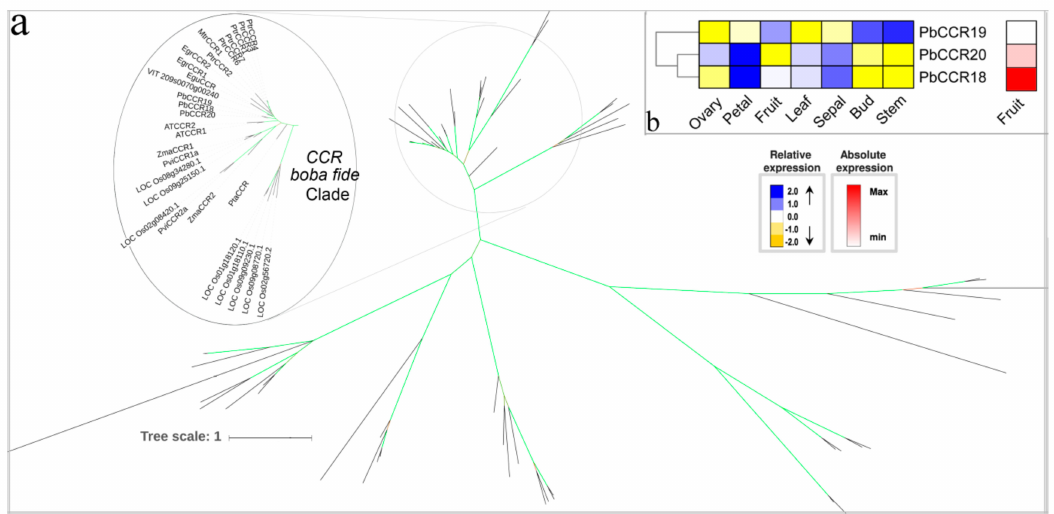
Figure 10. Phylogenetic tree and expression profiles of the CCR bona fide clade. ( a ) ML tree built with CCR bona fide enzymes from several species. ( b ) The expression profiles P. bretschneideri CCR bona fide genes. Subclade containing the bona fide genes is highlighted. The green color of the tree branches suggests strong node support (bootstrap support ≥ 95% and SH-aLRT ≥ 75%). The FPKM values of PbCCR genes in di ff erent tissues are indicated in Table S3. The gene accession number is indicated in Table S4, Figure S5. The tree scale is the number of amino acid substitution per